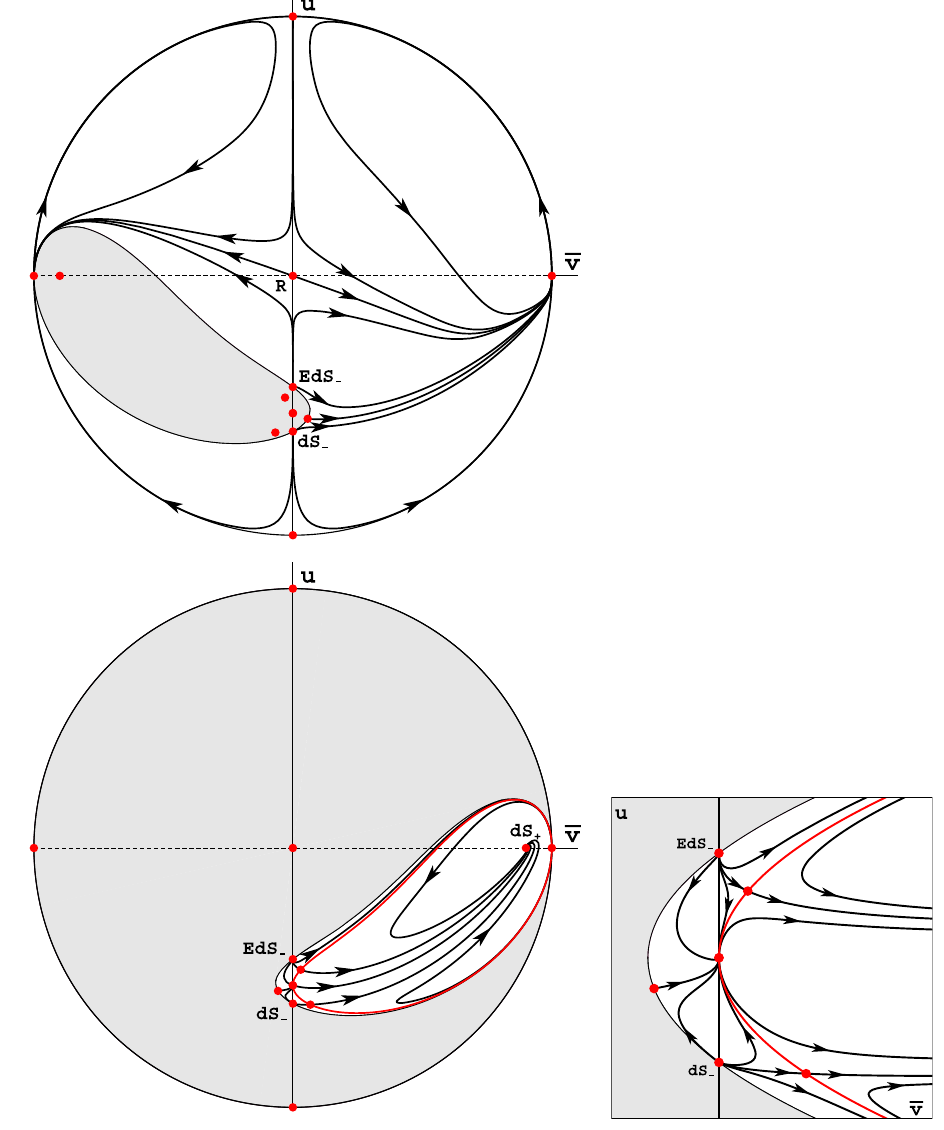
Fig. 2 The phase space diagrams representing evolutional paths of the decoupled part in the ( u , ¯ v) dynamical variables of the system (22) with λ = − 1 for 2 the canonical ε = + 1 (top) and the phantom ε = − 1 (bottom) scalar fields. The shaded regions of the phase space are unphysical where the energy conservation condition (21) is negative. Direction of arrows on the phase space trajectories indicates expansion of the universe. For λ > − 1 both the Einstein–de Sitter state EdS − and the de Sitter state dS − are unstable with respect to expansion of the